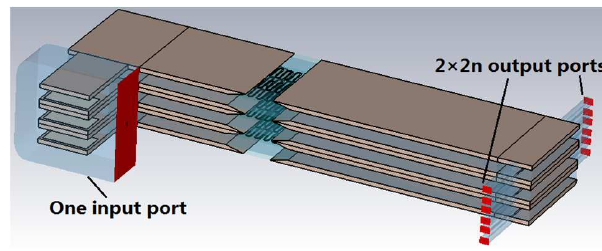
Figure 3. A possible framework for integrated 2 × 2n units.